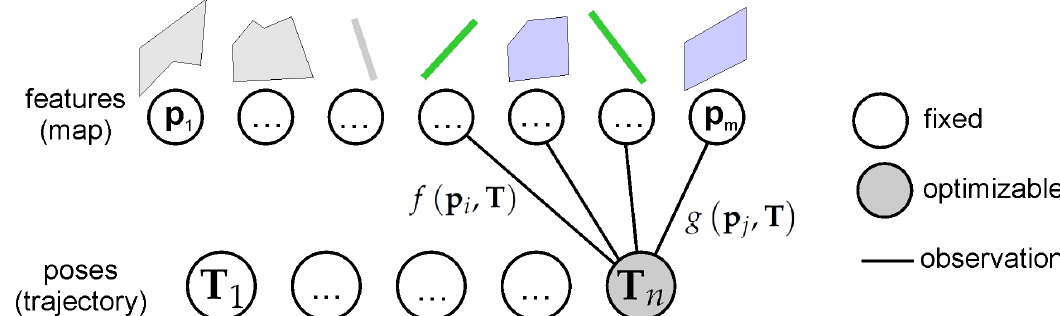
Figure 10. The optimization problem in PlaneLOAM mapping is solved by computing the current pose T using the point-to-line ( f ( p i , T ) ) and point-to-plane ( g ( p j , T ) ) constraints. Parameters of the observed features remain fixed during pose optimization. Compared to the LOAM approach, the parameters of each feature are stored explicitly in the